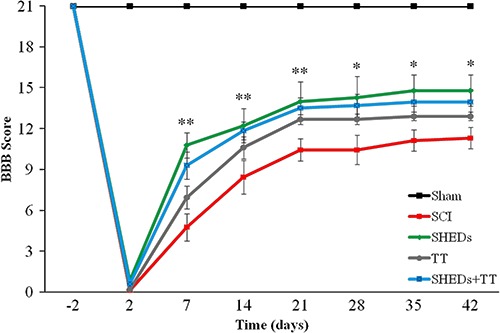
Progress of hind limbs functional recovery after incomplete spinal cord injury (SCI), as evaluated with the BBB scale, in sham operated (Sham), SCI, SCI treated with stem cells from human exfoliated deciduous teeth (SHEDs), SCI treated with treadmill training (TT), and SCI treated with SHEDs and treadmill training (SHEDs+TT) rats. Data are reported as means±SE. *Significantly different comparing the SHEDs group to the SCI group; **significantly different comparing the SHEDs and the SHEDs+TT groups to the SCI group. Statistical analysis was performed using repeated-measures ANOVA to detect treatment effects over time, and individual one-way ANOVA followed by Tukey's post hoc were performed to observe intraday differences among groups (P<0.05). BBB: Basso, Beatie, and Bresnahan scale.